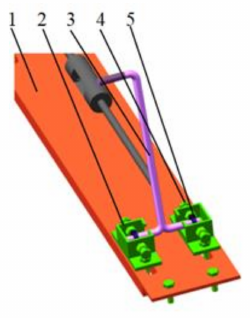
Figure 7. Structural diagram of concave screen support device: 1. plane fixing plate; 2. concave screen support base; 3. isosceles connecting rod; 4. micro adjustment bolt; 5. horizontal displacement